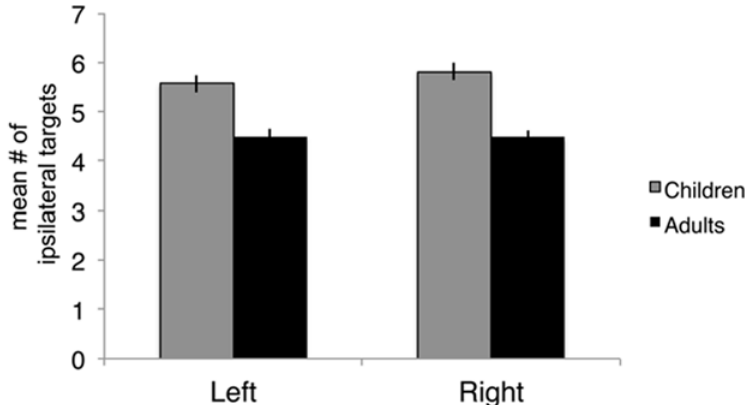
Fig 3. Mean number of ipsilateral target regions that the amygdala connects with in children and adults. Each amygdala voxel ’ s connectivity vector to all other target regions is thresholded at 0.1, binarized, and averaged across the amygdala per individual. In children, the amygdala showed connectivity (above 0.1) to a greater number of target regions on average than adults in both left (C: 5.57 ± 0.18, A: 4.50 ± 0.16) and right (C: 5.81 ± 0.18, A: 4.48 ±